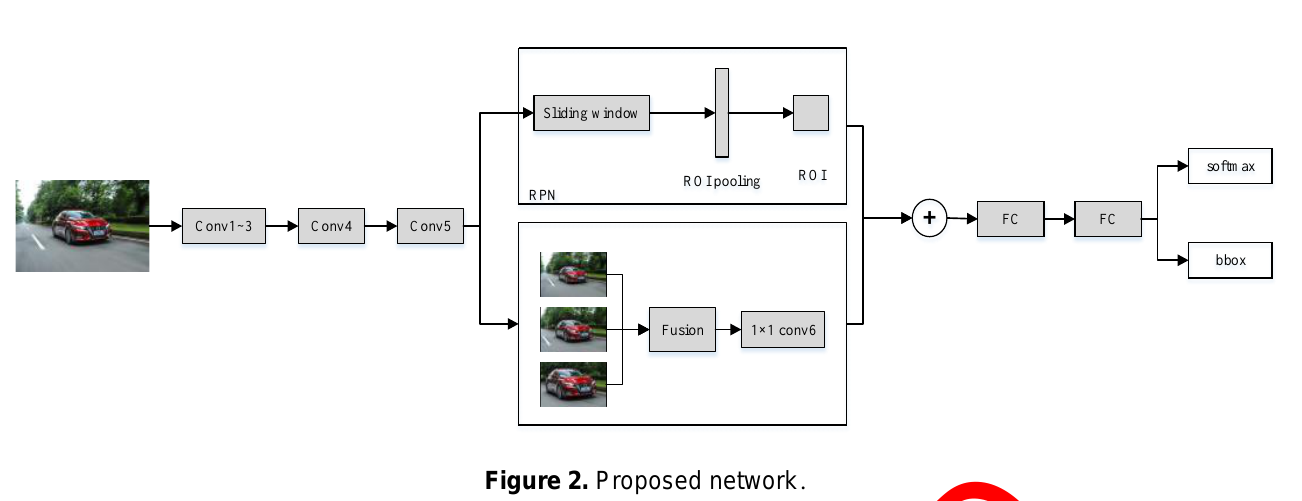
Figure 2. Proposed network .